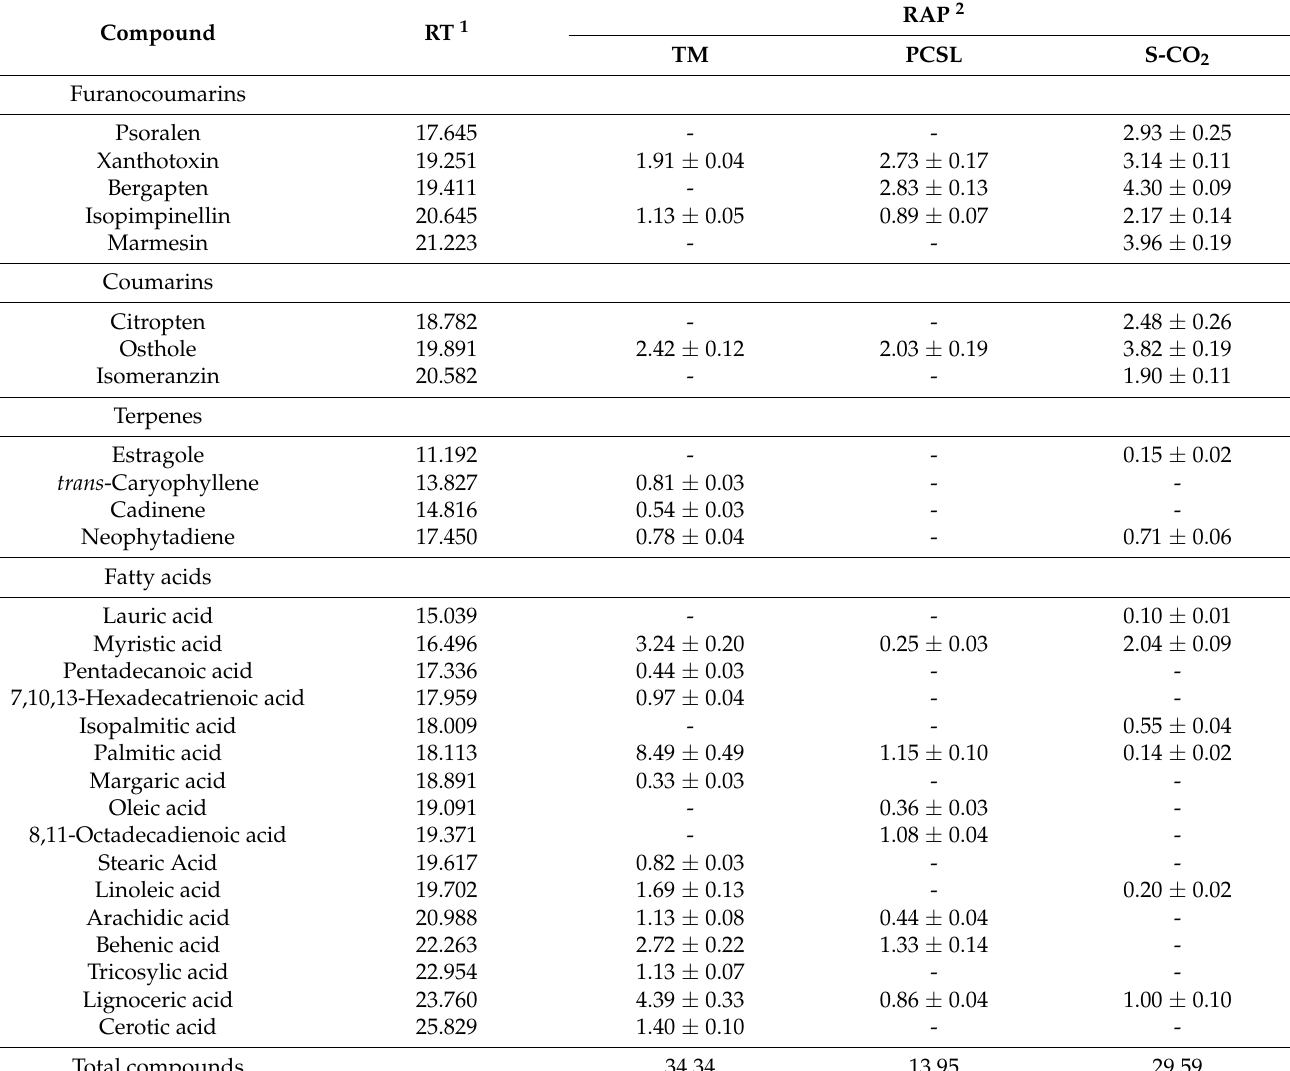
Table 2. Phytochemical profile of Prangos ferulacea Lindl.